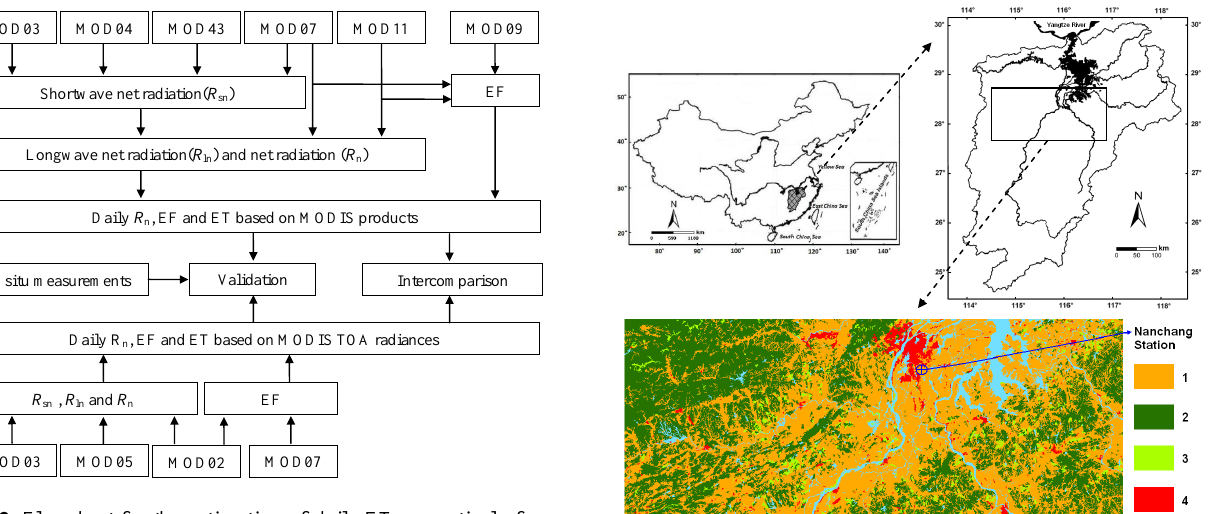
Fig. 2. Flowchart for the estimation of daily ET respectively from various MODIS products and the MODIS TOA radiances using the triangle method, and the validation of the satellite retrievals with in situ measurements.